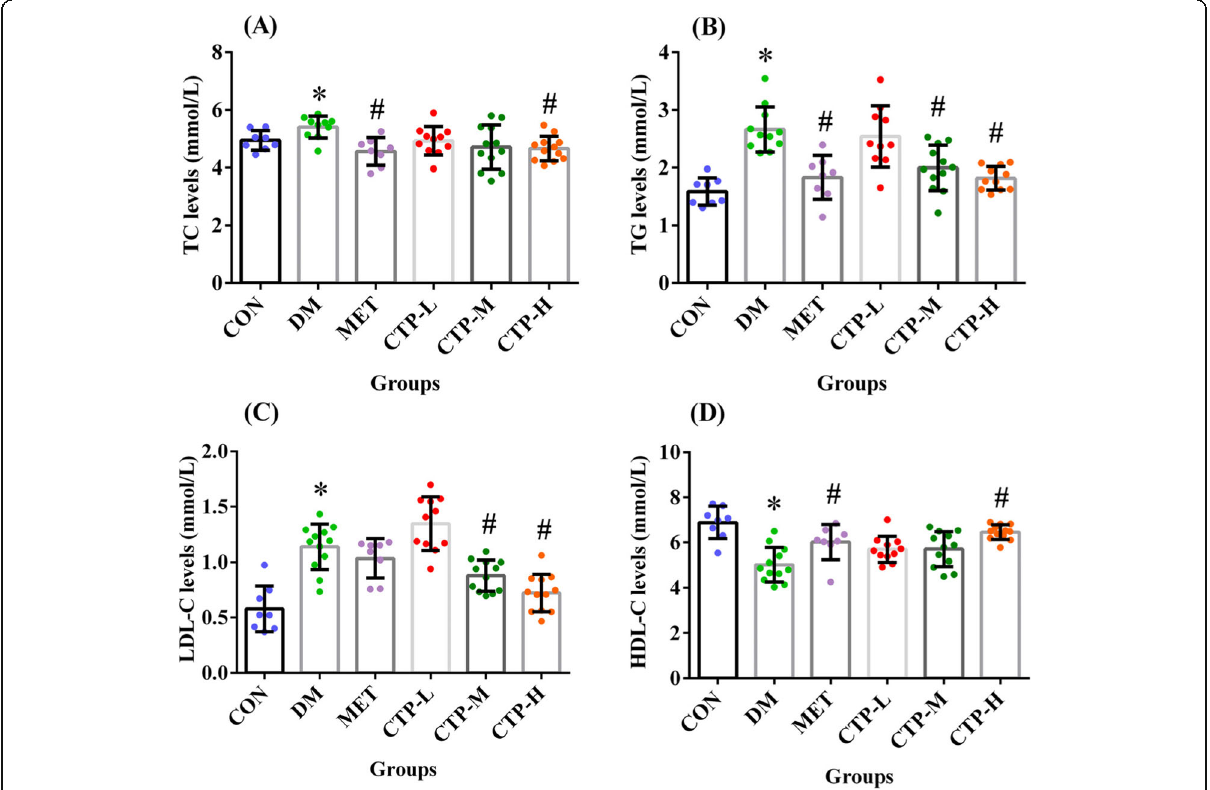
Fig. 3 Effects of CTP on serum lipid levels in diabetic mice. The following values were measured 28 days after CTP was administered: ( a ) Serum TC level. b Serum TG level. c Serum LDL-C level. d Serum HDL-C level. Data are presented as mean ± SD ( n = 8 – 12). * p < 0.05 as compared with CON. # p < 0.05 as compared with